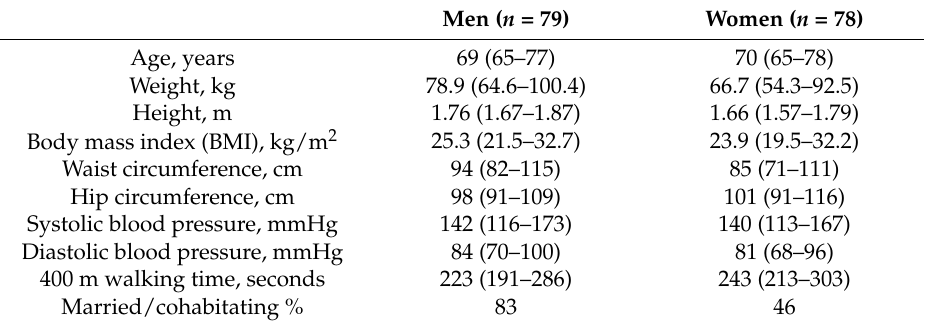
Table 1. Baseline characteristics for the study population (values are presented as medians and